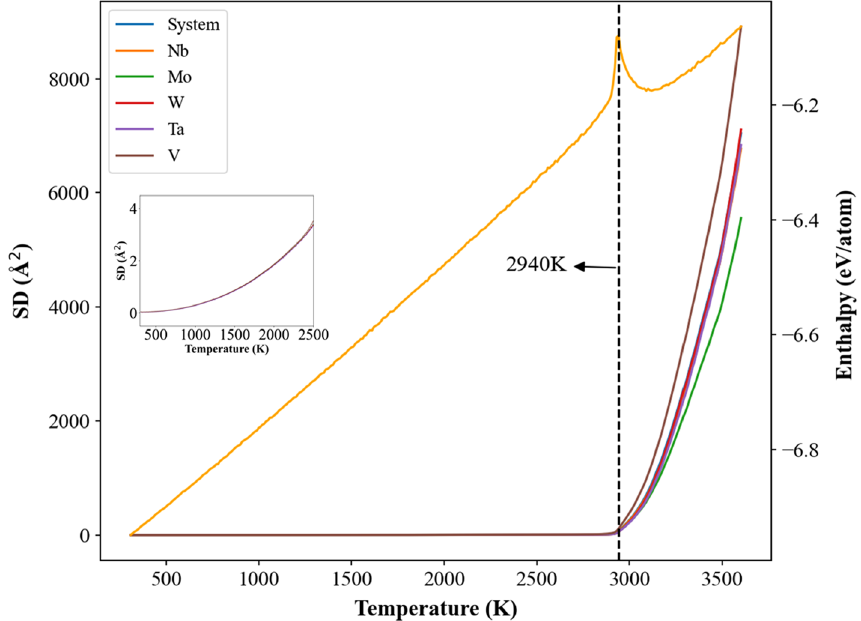
Figure 6. The square displacement (SD) and enthalpy profiles of system, Nb, Mo, W, Ta, and V during the heating process for the single crystal Nb 20.6 Mo 21.7 Ta 15.6 W 21.1 V 21.0 RHEA. The insert shows SD profiles at temperatures lower than the melting point of 2940